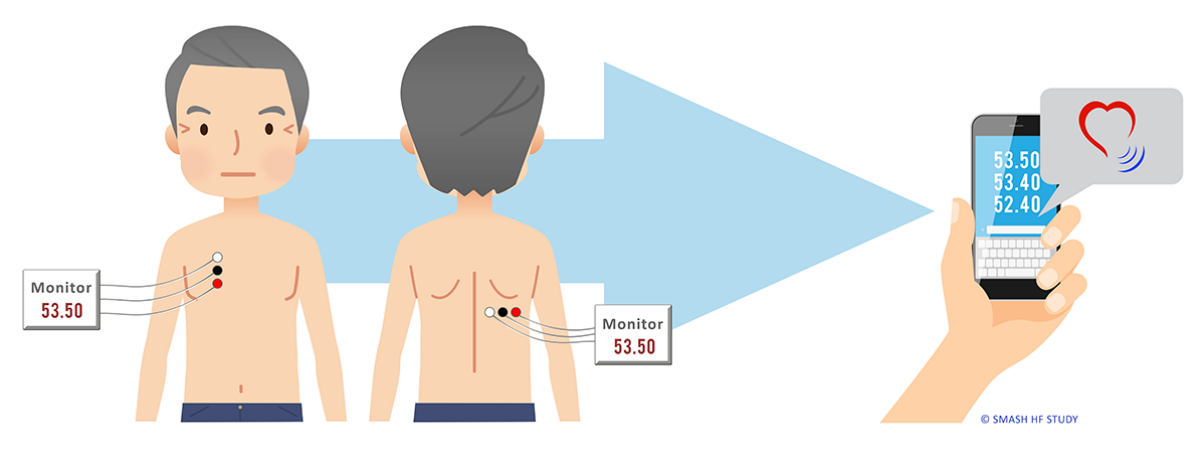
Figure 1. Measurement of noninvasive lung impedance at home and sending impedance data to the study center by SMS. Schematic illustration shows the correct placement of the 6 Edema Guard Monitor electrodes on an HF patient, measurement of impedance, and how daily measurement data are sent by mobile phone